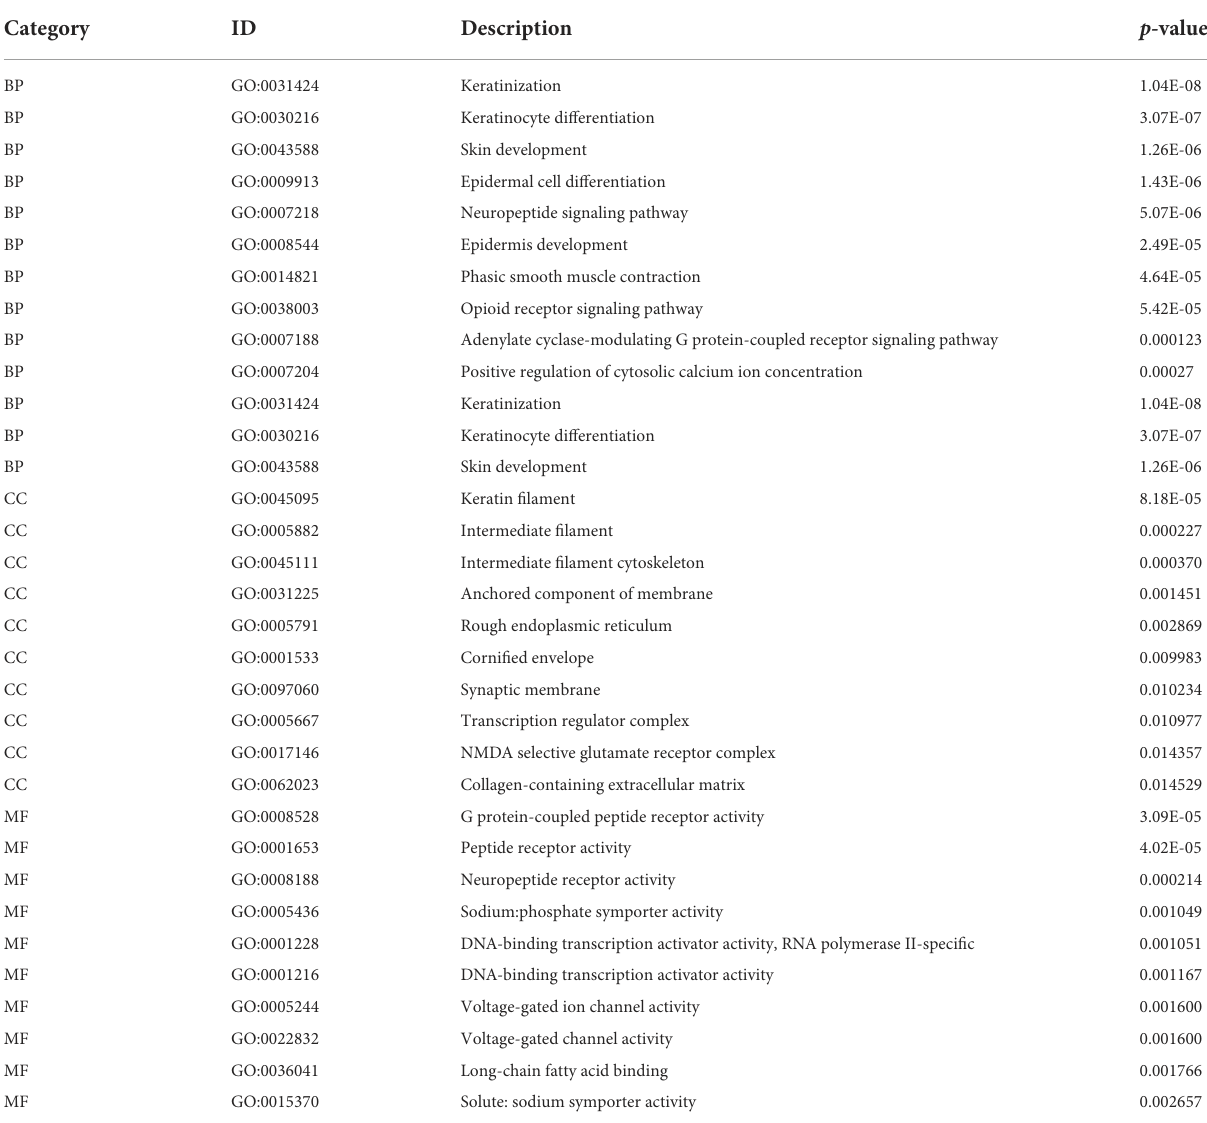
TABLE 2 Top 10 GO and KEGG enrichment of